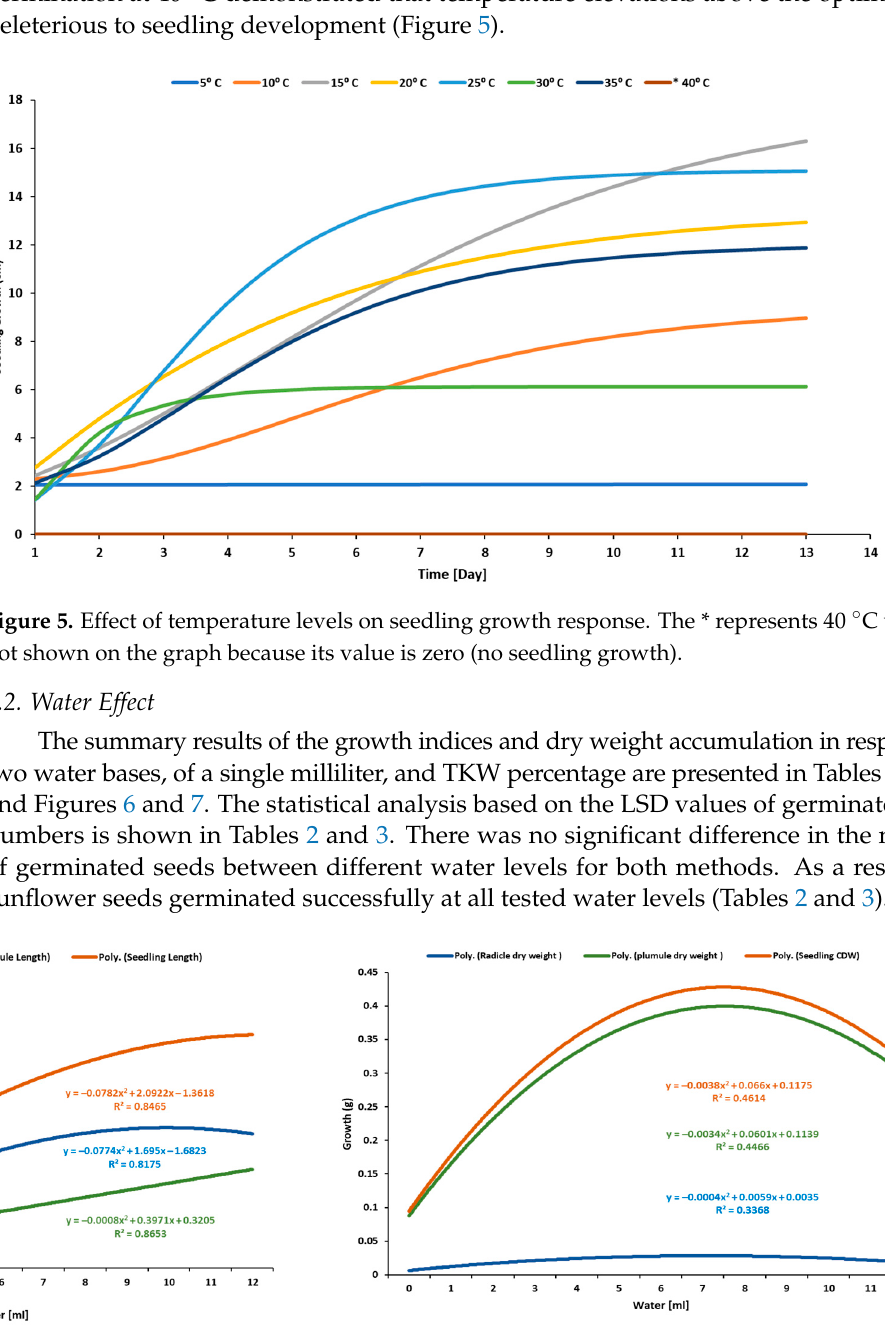
Table 3. Mean comparison of germination and seedling growth characteristics for varying amounts of water depending on TKW%.